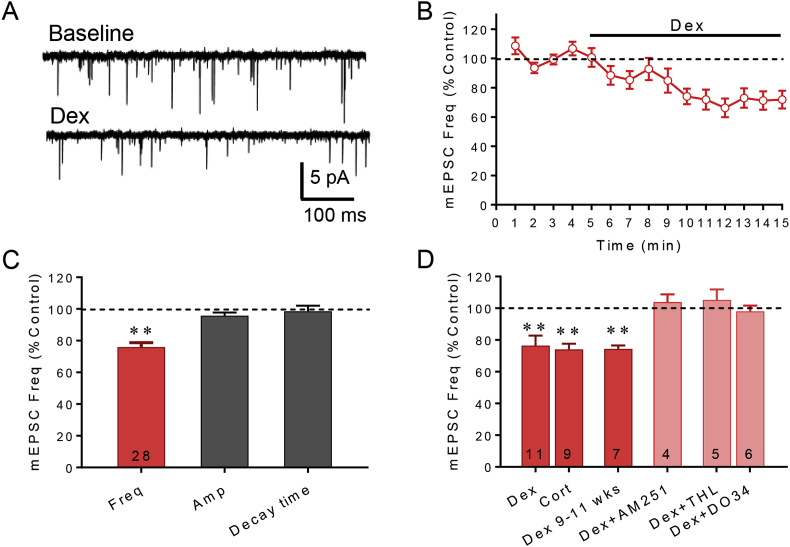
Glucocorticoids rapidly suppress excitatory synaptic inputs to magnocellular neurons by causing 2-AG release. A. Representative traces showing the effect of bath application of the synthetic glucocorticoid agonist dexamethasone (Dex) on mEPSCs. B. Running average of mEPSC frequency indicates that the Dex effect is rapid, occurring within minutes (n = 11). C. Summary bar graph of effect of Dex (1 μM) on mEPSC frequency, amplitude, and decay time. Dex decreased the mEPSC frequency but had no effect on the mEPSC amplitude or decay, indicating a presynaptic effect. D. Corticosterone (Cort, 1 μM) also caused a decrease in the frequency of mEPSCs. The Dex-dependent decrease in mEPSC frequency was found in magnocellular neurons from both 4-6 week-old (Dex) and 9-11 week-old (Dex 9–11 wks, p < 0.01, n = 7) animals, and was blocked by the CB1 antagonist AM251 (4 μM, n = 4) and the DAG lipase inhibitors tetrahydrolipstatin (THL, 25 μM, n = 5) and DO34 (1 μM, n = 7). Numerals in bars = cell numbers in this and all figures. *, p < 0.05; **, p < 0.01.